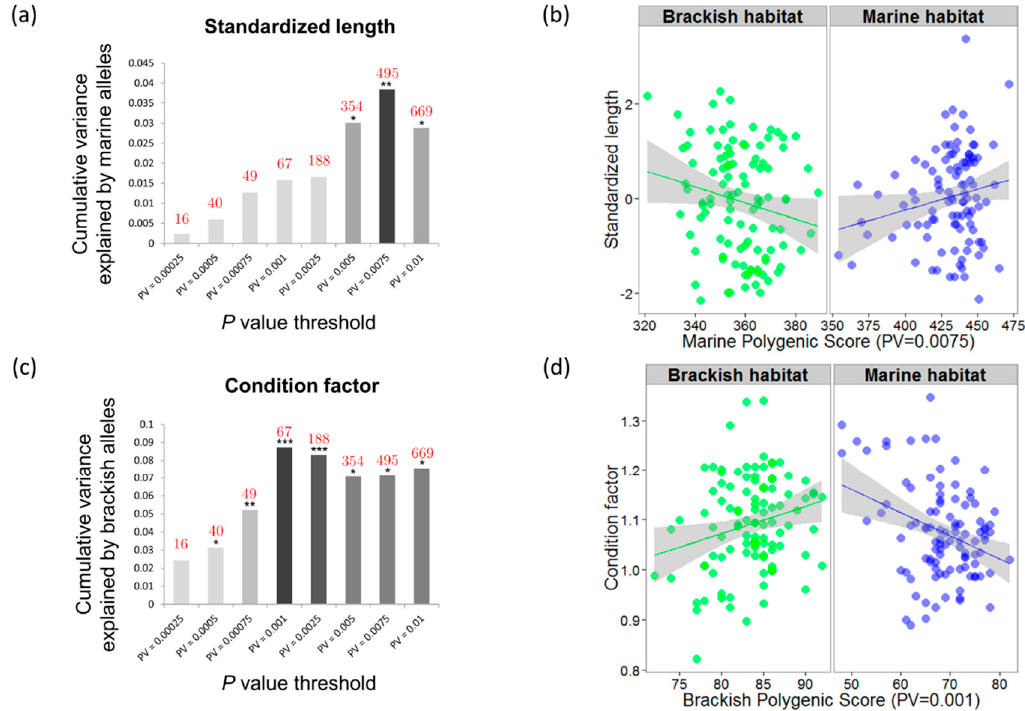
Figure 4. Phenotypic variance explained by outlier loci. ( a ) The cumulative variance in standardized length (y axis) explained by marine-favored alleles increases when outlier single nucleotide polymorphisms (SNPs) reaching lower significance thresholds (x axis) are included in the ANCOVA model (interaction term: P < 0.05 *, < 0.01 **, < 0.001 ***). The number of outlier SNPs corresponding to each significance threshold appears in red. The maximum amount of explained phenotypic variance is attained for a total of 495 outliers detected at a nominal significance threshold of 0.0075. ( b ) Genotype–environment interaction for standardized length assessed with an ANCOVA model using individual marine polygenic scores calculated with 495 outliers ( R 2 = 0.0385, interaction term: P = 6.5 × 10 − 3 ). ( c ) The cumulative variance in condition explained by brackish-favored alleles is maximized for 67 outlier loci detected at a P -value threshold of 0.001. ( d ) Genotype–environment interaction for condition assessed with an ANCOVA model using individual brackish polygenic scores calculated with 67 outliers ( R 2 = 0.0871, interaction term: P = 1.7 × 10 − 4 ).